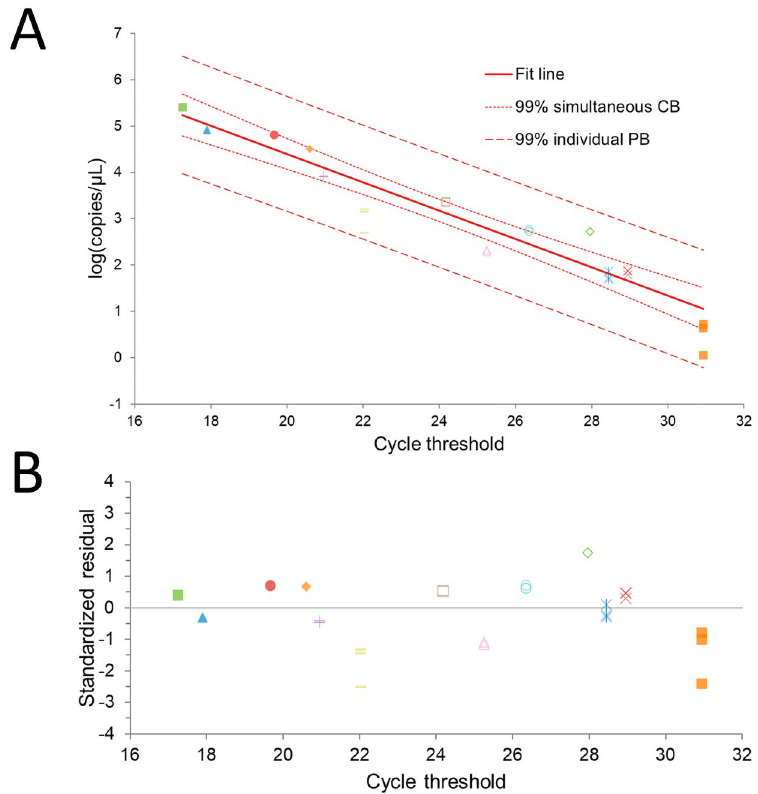
Fig 3. Linearity fitting of the linear logistic model establishing the relationship between the cycle threshold values and the actual viral loads. A) Linearity fitting plot including the individual plot of replicates (of the same colour) and the fitting line of linearity with the respective confidence bands and individual bands at the 99% level. B) Standardised residual plot: there are only two replicates of two different samples outside the 2 standard deviations.